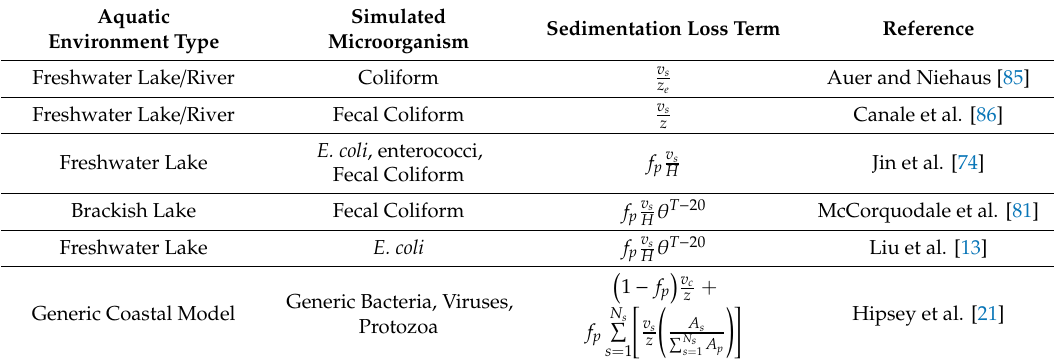
Table 3. Sedimentation loss terms used in contaminant fate and transport